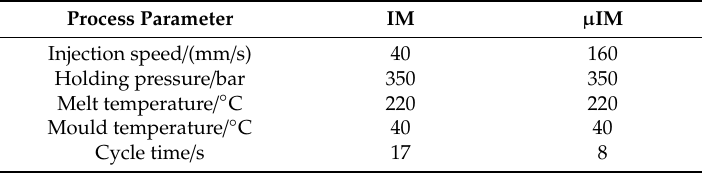
Table 1. Process parameters for IM and µ IM, Reproduced with permission from